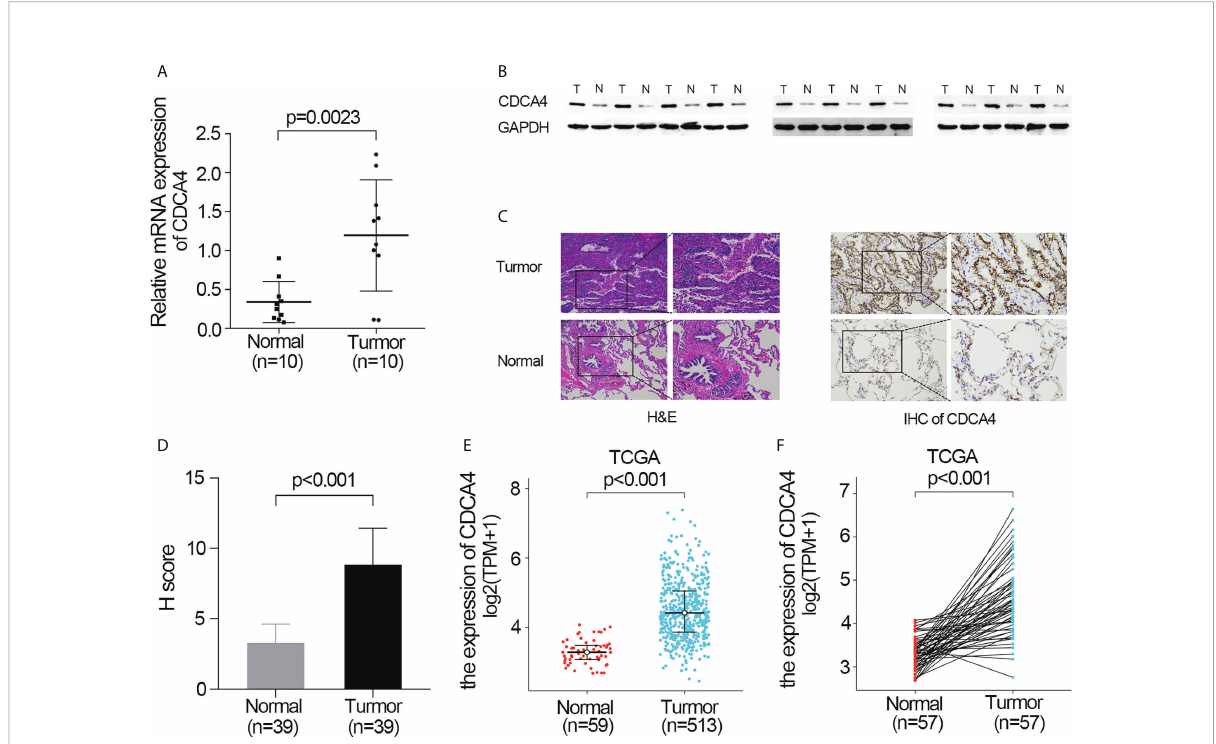
FIGURE 1 Validate the expression of CDCA4 in LUAD. (A) qRT-PCR was used to identify the expression of CDCA4 mRNA in tumors and adjacent tissues of 10 LUAD patients. (B) Western blotting was used to determine the expression of CDCA4 protein in tumors and adjacent tissues of 10 LUAD patients. (C) CDCA4 expression in LUAD tissues and adjacent normal tissues assayed by IHC (×200) and (×400). (D) H score of IHC staining of LUAD tissues and adjacent tissues. (E) CDCA4 mRNA levels in LUAD tissues from the TCGA database. (F) CDCA4 mRNA expression levels in the tumors and adjacent tissues of 57 LUAD patients from the TCGA database. Data are expressed as mean standard deviation (SD). Normal, lung tissue; tumor, lung adenocarcinoma tissue; TCGA, The Cancer Genome